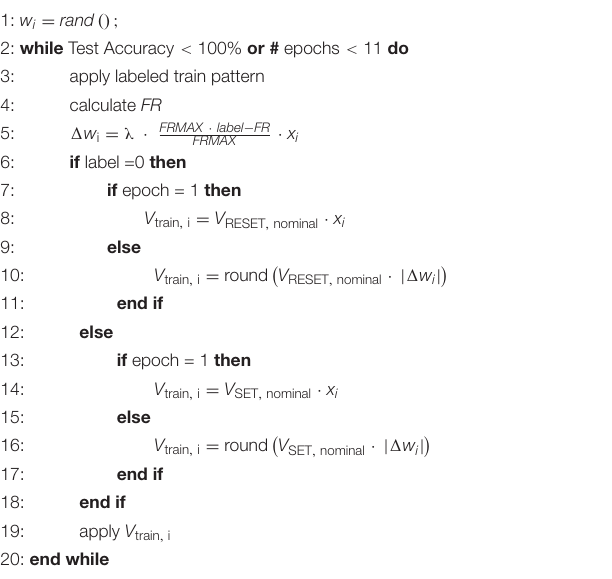
Algorithm 1 : Delta Rule implementation with stochastic